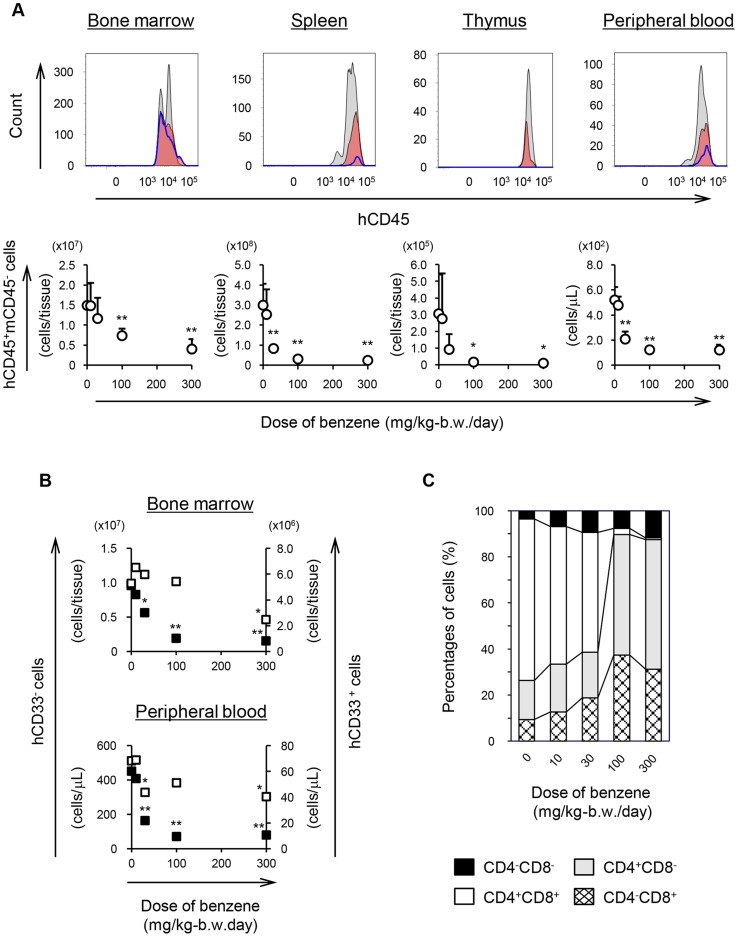
Benzene toxicity in human leukocytes from Hu-NOG mice.(A) Human leukocytes collected from the peripheral blood and hematopoietic organs of Hu-NOG mice. Upper panel: histogram of hCD45+mCD45− cells in Hu-NOG mice administered 0 (gray), 30 (red), or 300 mg (blue-lined) benzene/kg-b.w./day. Lower panel: numbers of hCD45+mCD45− cells in Hu-NOG mice. Each point represents the mean ± SD of each group (n = 7 or n = 8). * p<0.05 and ** p<0.01 represent significant differences compared with untreated mice, as determined by t tests. (B) Numbers of human myeloid and lymphoid cells in the bone marrow or peripheral blood of Hu-NOG mice. Human myeloid cells were identified as hCD45+mCD45−hCD33+ cells (open square). Human lymphoid cells were identified as hCD45+mCD45−hCD33− cells (solid square). Each point represents the mean of each group (n = 7 or n = 8). * p<0.05 and ** p<0.01 represent significant differences compared with untreated mice as determined by t tests. (C) The percentage of each T cell population in the thymus of Hu-NOG mice. The value was calculated based on the ratio of hCD45+mCD45−hCD33− cells. Individual types of T cells were determined by using combinations of anti-hCD4 and hCD8 antibodies. Values represent means (n = 7 or n = 8).